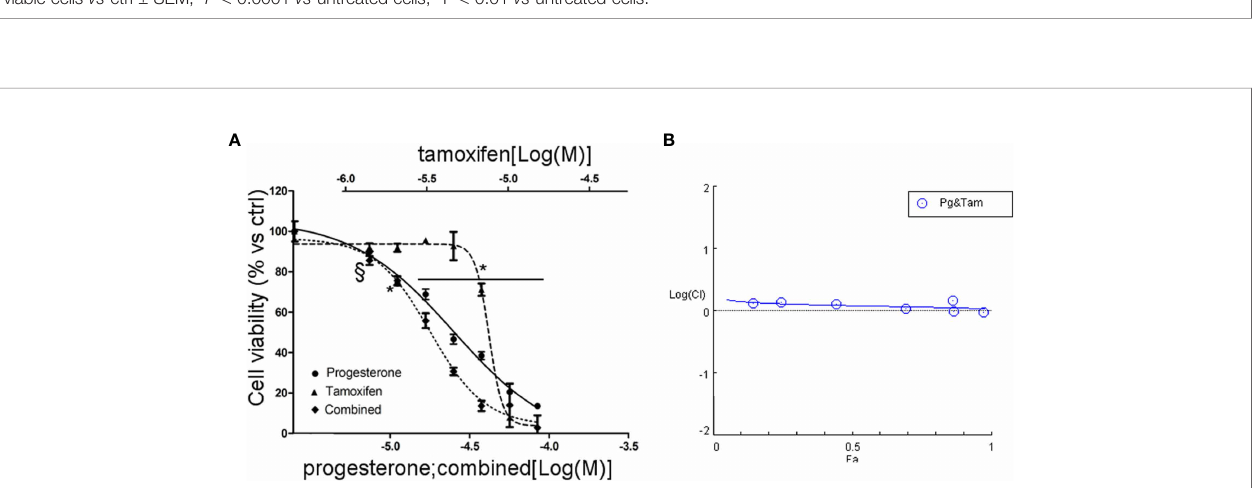
FIGURE 5 | Cytotoxic effect of Pg in ACC cell models. (A) MUC-1 cell line and ACC115m primary culture were treated with increasing concentrations of progesterone (0.1 – 160 uM), then cell viability was analyzed by MTT assay, (B) NCI-H295R, MUC-1 cell lines and ACC115m primary culture were treated with low, intermediate, and high dose of Pg, and cell proliferation was analyzed by directing counting with trypan blue discrimination. Results are expressed as percent of viable cells vs ctrl ± SEM; * P < 0.0001 vs untreated cells; # P < 0.01 vs